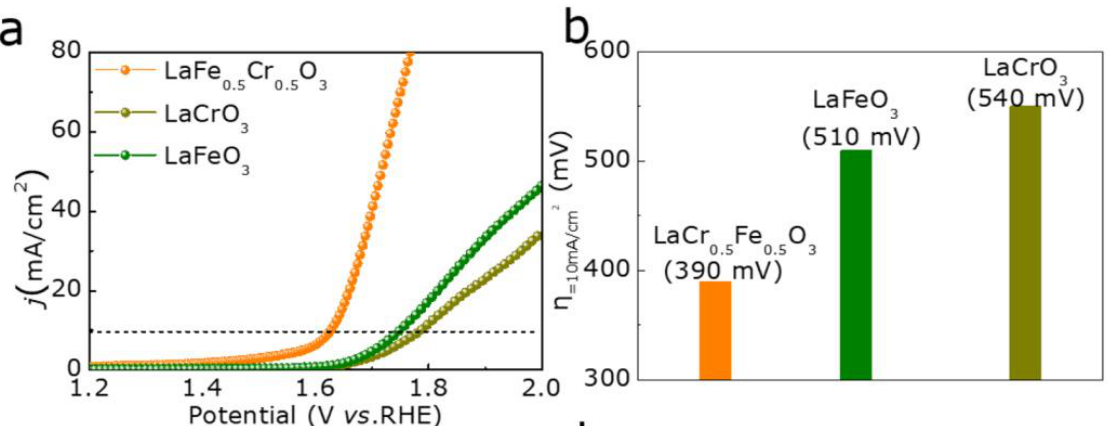
Figure 12. ( a ) The polarization curves and ( b ) overpotential at 10 mA/cm 2 of LaFeO 3 , LaCrO 3 and LaCr 0.5 Fe 0.5 O 3 for OER. Copyright 2020 by the Springer Nature [94].